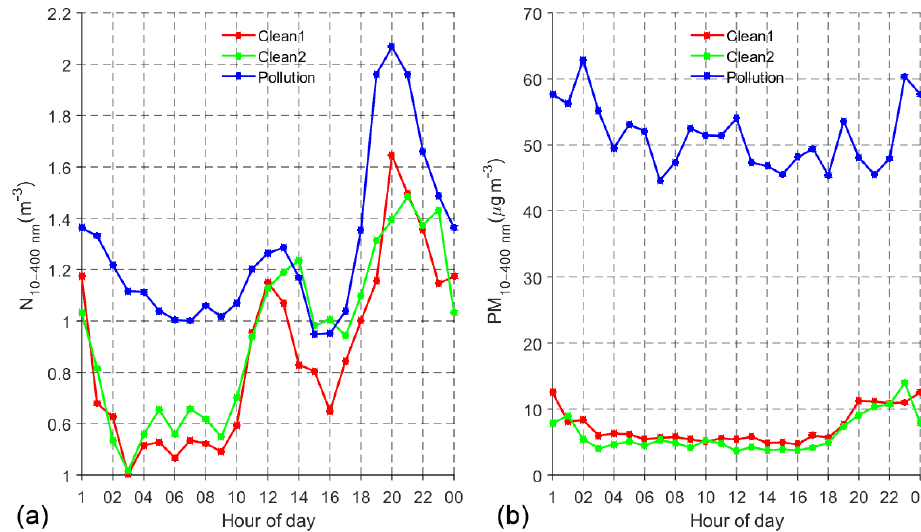
Figure 4. Diurnal variation in mobility diameter ( D p ) 10–400nm particles (a) number concentration ( N 10 − 400nm ) and (b) mass concentra- tion (PM 10 − 400nm ) for the Clean1 (in red), Clean2 (in green), and Pollution (in blue)